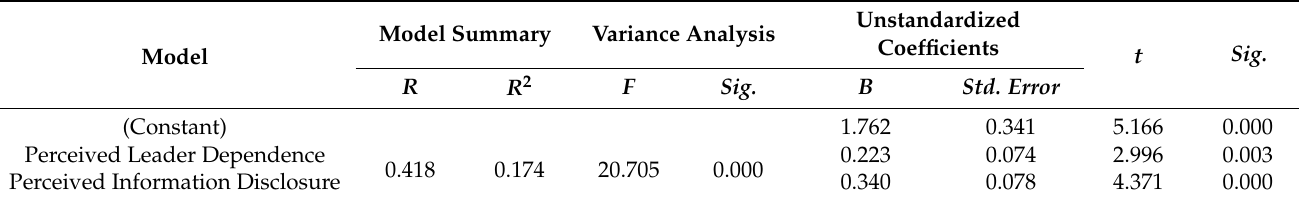
Table 15. Regression Analysis of Perceived Leader Trust on Ability.